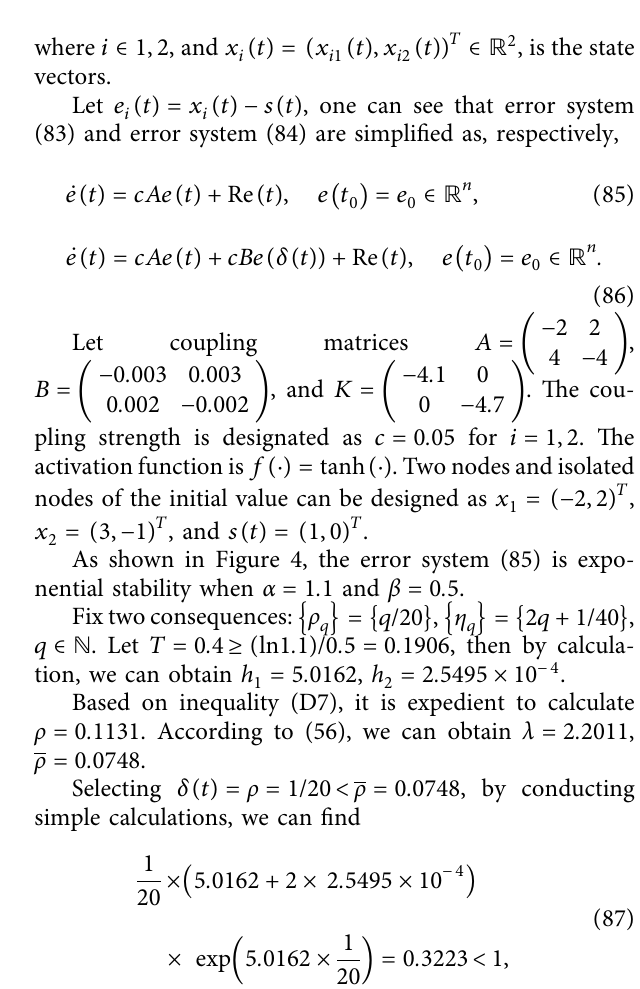
Figure 2: The convergent behavior of the error system under a nonlinear control